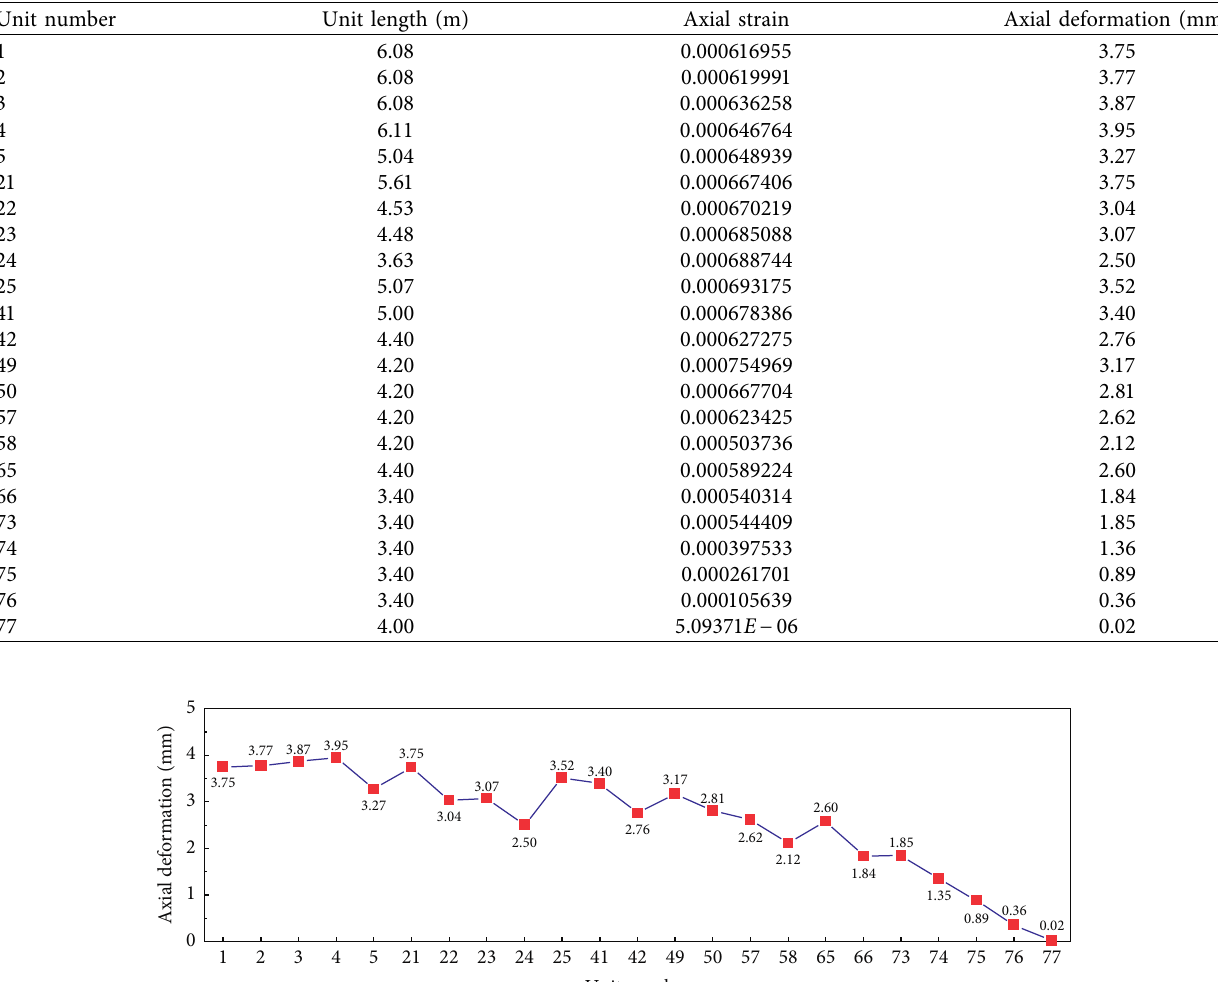
Figure 9: Strain energy distribution: (a) the first mode; (b) the second mode. Table 2: Axial deformation of each main tower column for the first mode.